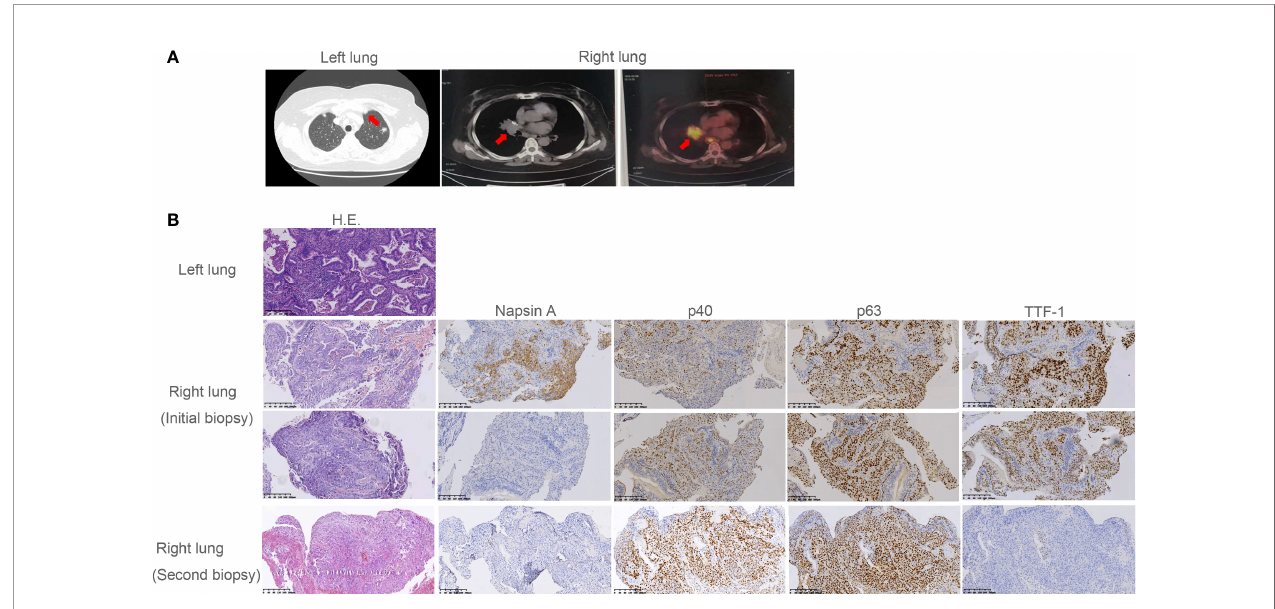
FIGURE 1 | Radiographic imaging at diagnosis and pathological fi ndings. (A) The subsolid nodule under the pleura of the upper left lobe and the soft tissue density nodule in the right middle lobe and near the hilum revealed by computed tomography (CT) or positron emission tomography (PET). (B) Pathological examination revealed the subsolid nodule under the pleura of the upper left lobe was adenocarcinoma. Pathology showed the initial and the second biopsy of soft tissue density nodule in the right lung were adenosquamous carcinoma and squamous carcinoma, respectively. Interpretation of immunohistochemistry (IHC) performed on the initial biopsy was challenging as most tumor cells were TTF-1 positive suggesting adenocarcinoma. However, there was clear and diffuse positivity for p40 in some cells with corresponding lack of Napsin A. This suggested both glandular and squamous differentiation. In the second biopsy, p40 was diffuse with complete lack of adenocarcinoma markers TTF-1 and Napsin A, consistent with squamous cell